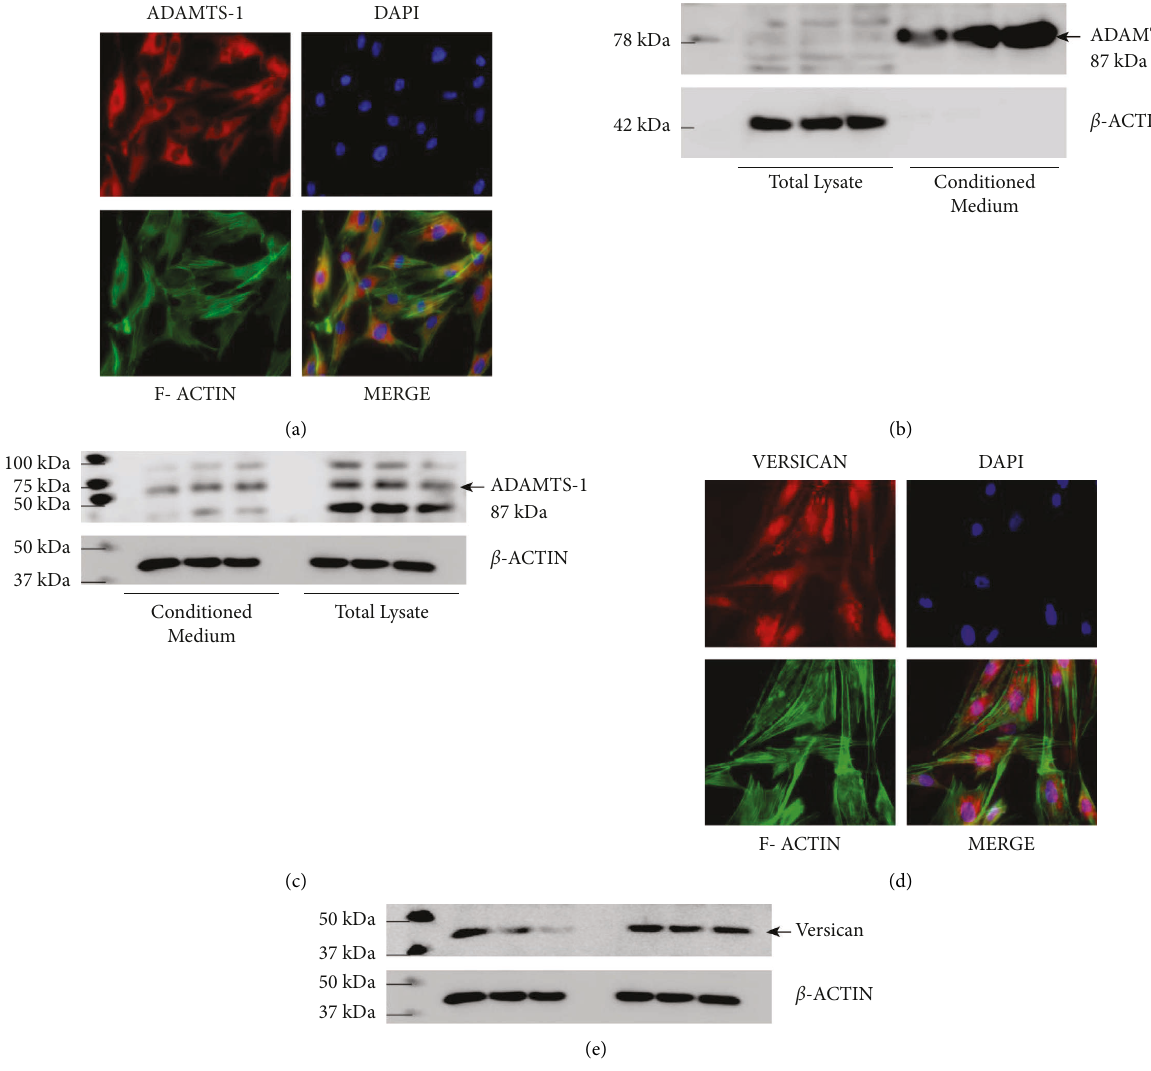
Figure 3: ADAMTS-1 and versican levels on AME cells line. ADAMTS-1 immunolocalization on AME cells shows cytoplasmic localization (red channel). (a) Immunoblot from cell lysate and conditioned medium. (b) Immunoblot from conditioned medium and total lysate after treatment with 2 μ M of monensin. (c) Loading control with β -actin (b). Versican immunolocalization on AME cells shows cytoplasmic and nuclear distribution (red channel). (d) Immunoblot from cell lysate and conditioned medium. (e) kDa: